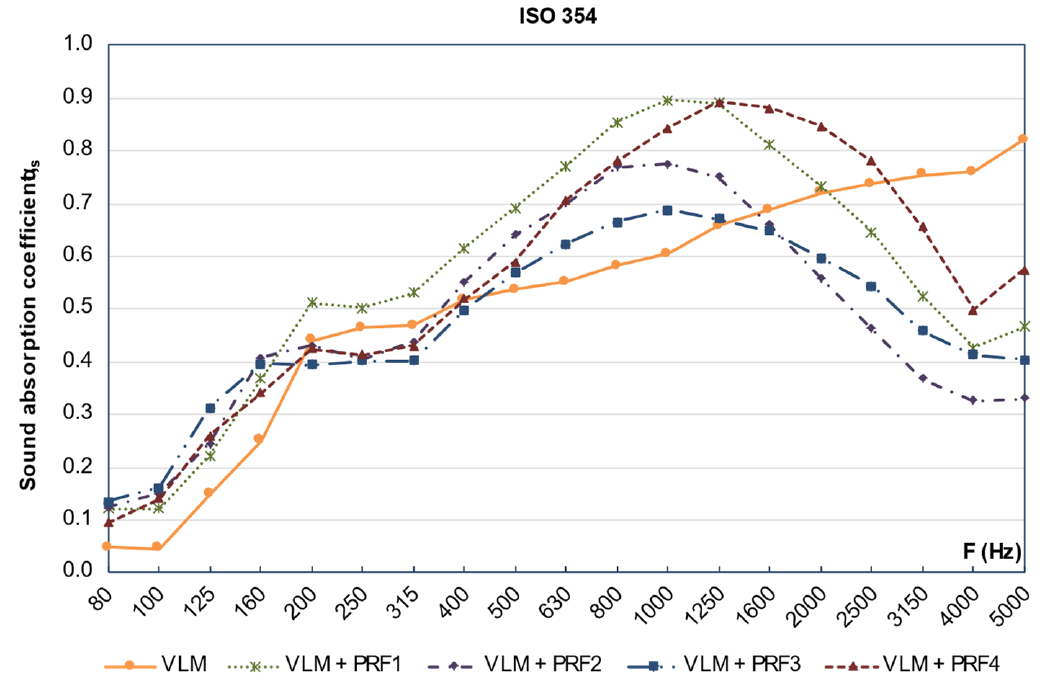
Figure 9. ISO 354 results for the assessed configurations. Table 5. UNE-EN ISO 11654 results and classification.